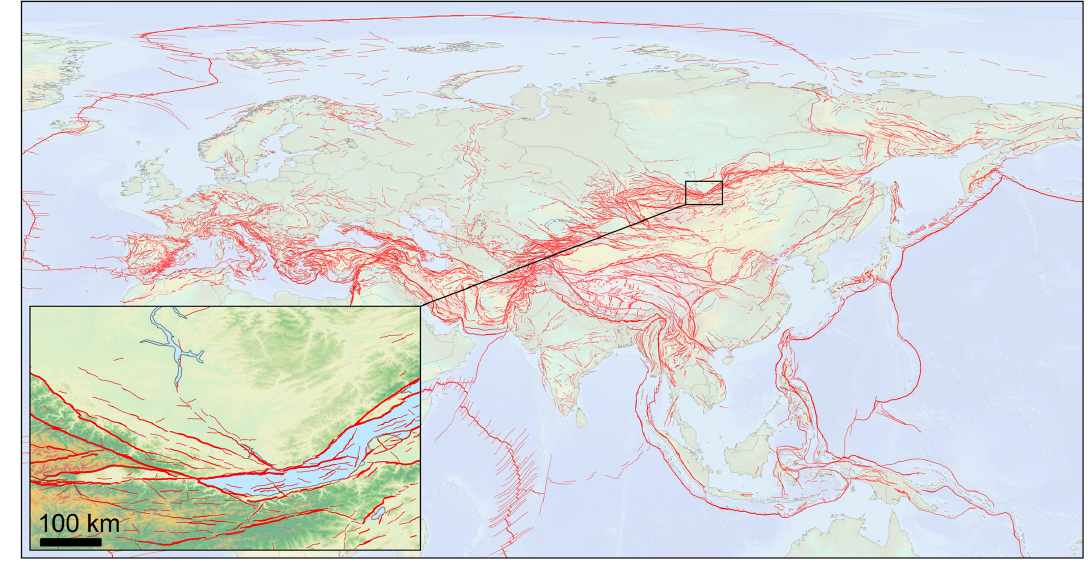
Figure 1. Overview and detail of the Active Faults of Eurasia Database